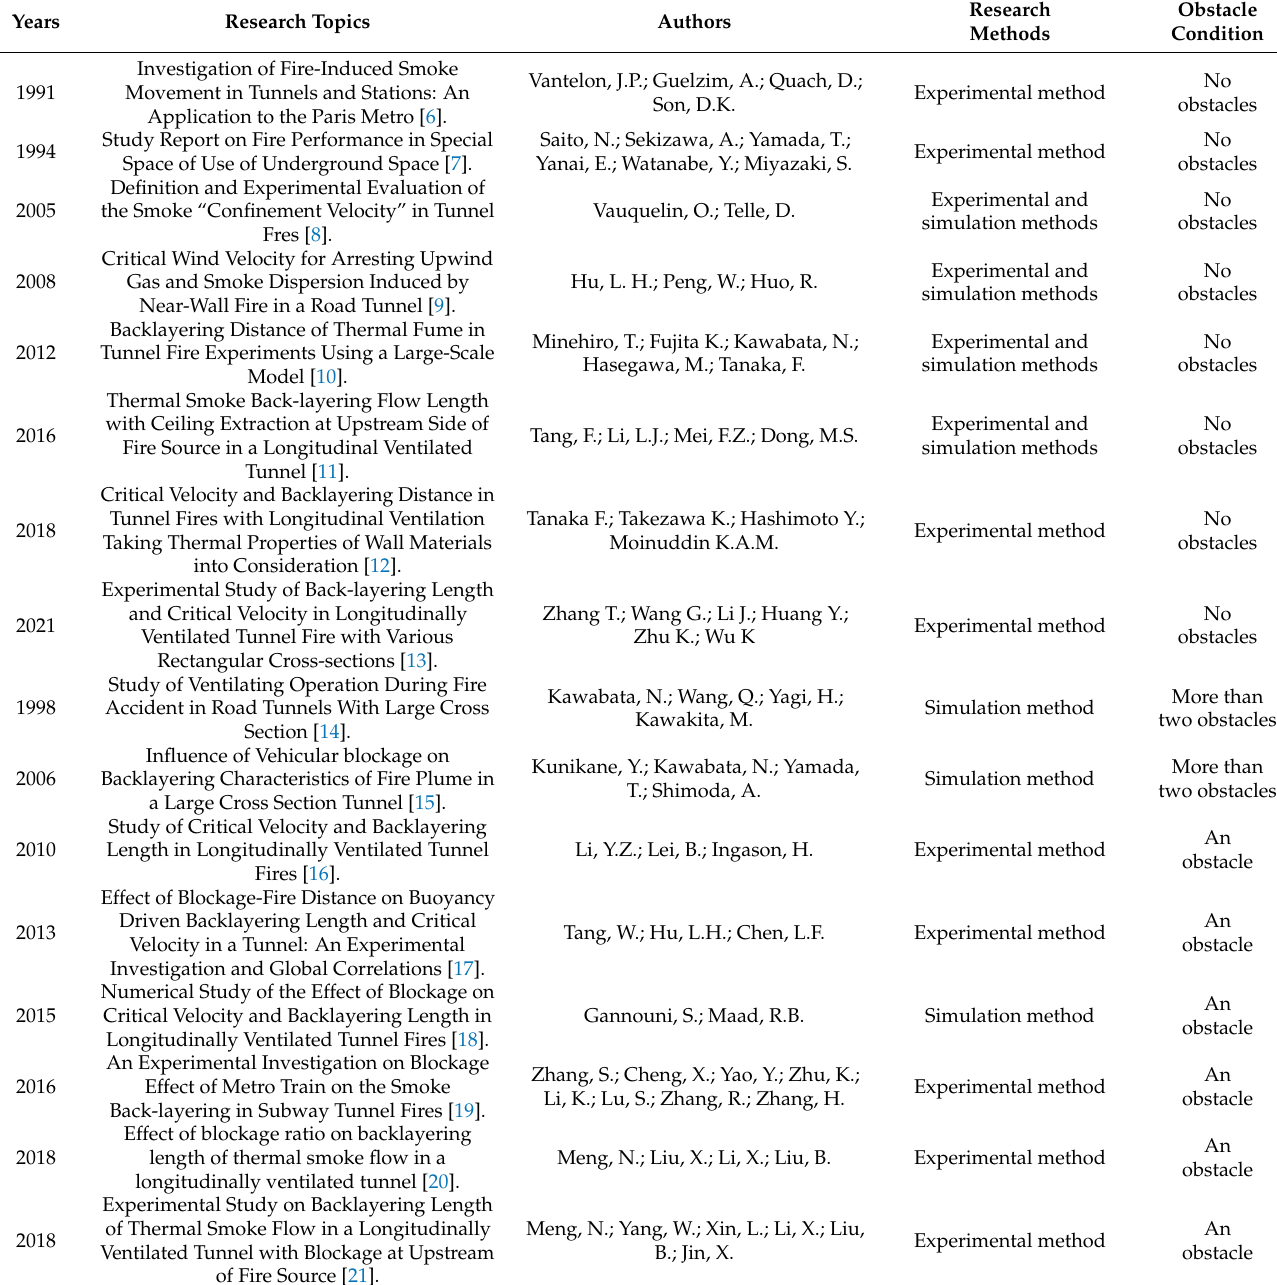
Table 1. List of studies on backlayering